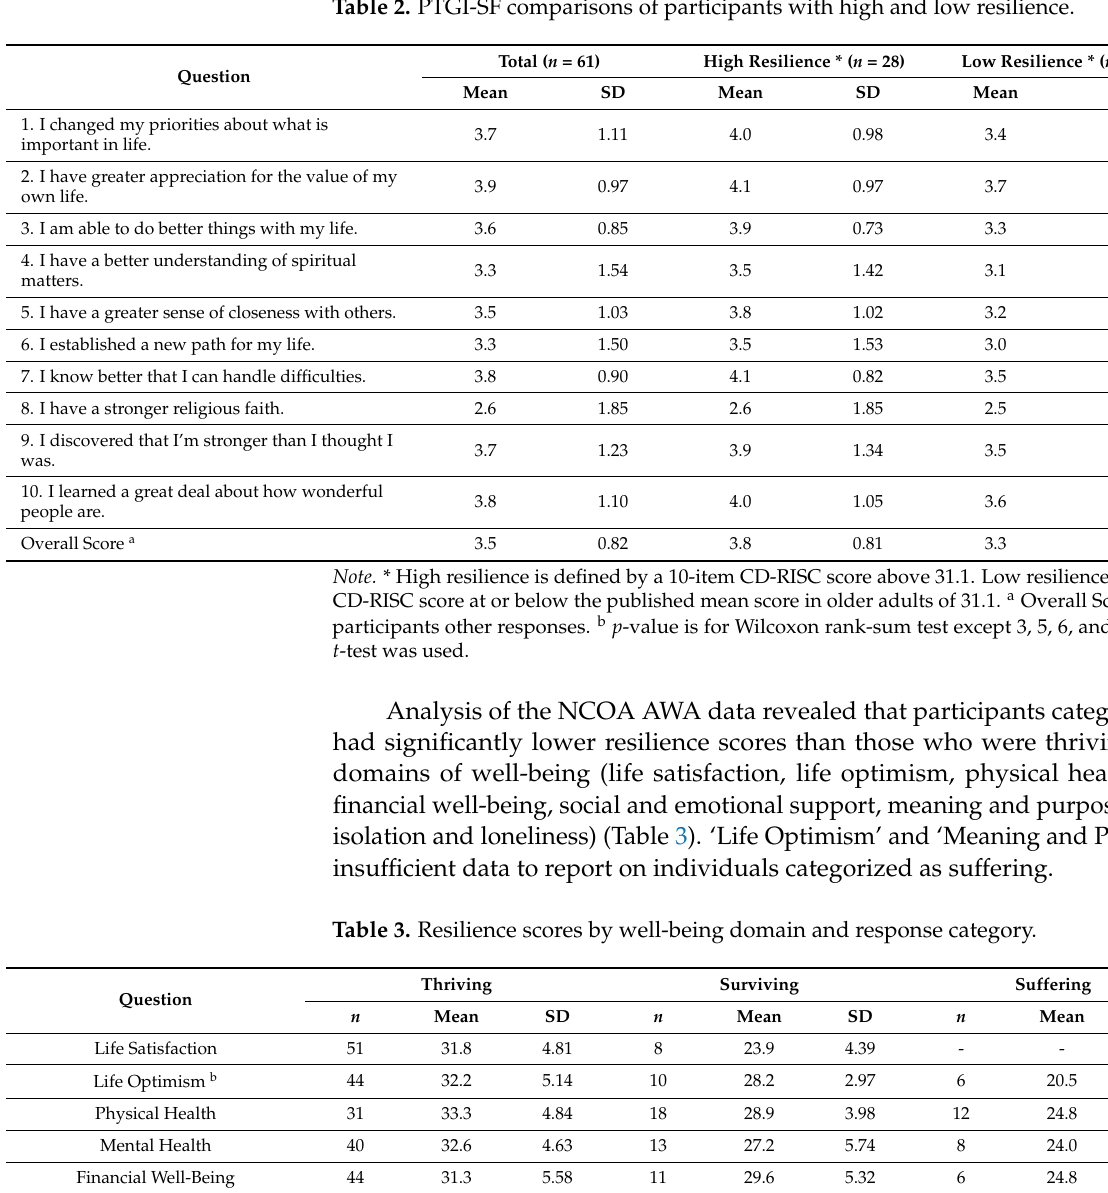
Table 2. PTGI-SF comparisons of participants with high and low resilience.